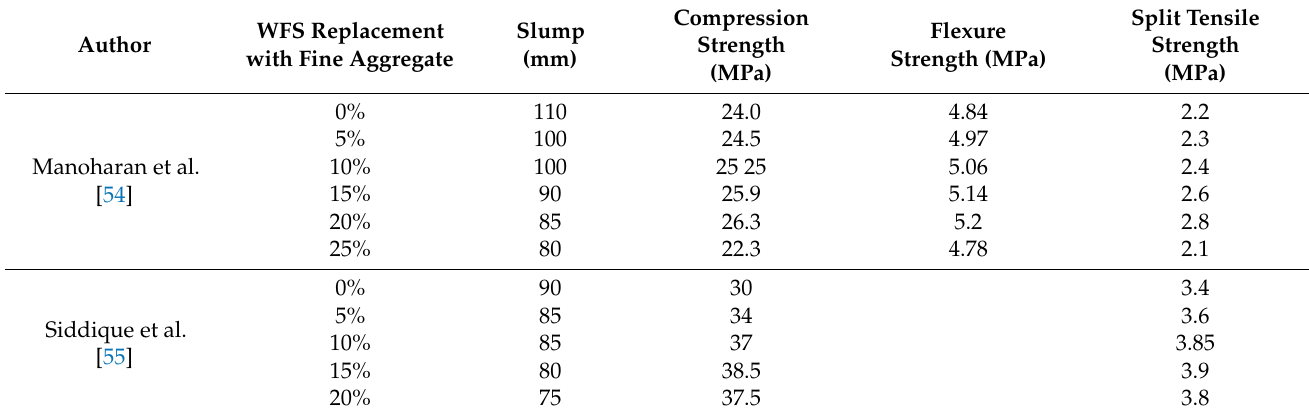
Water Absorption